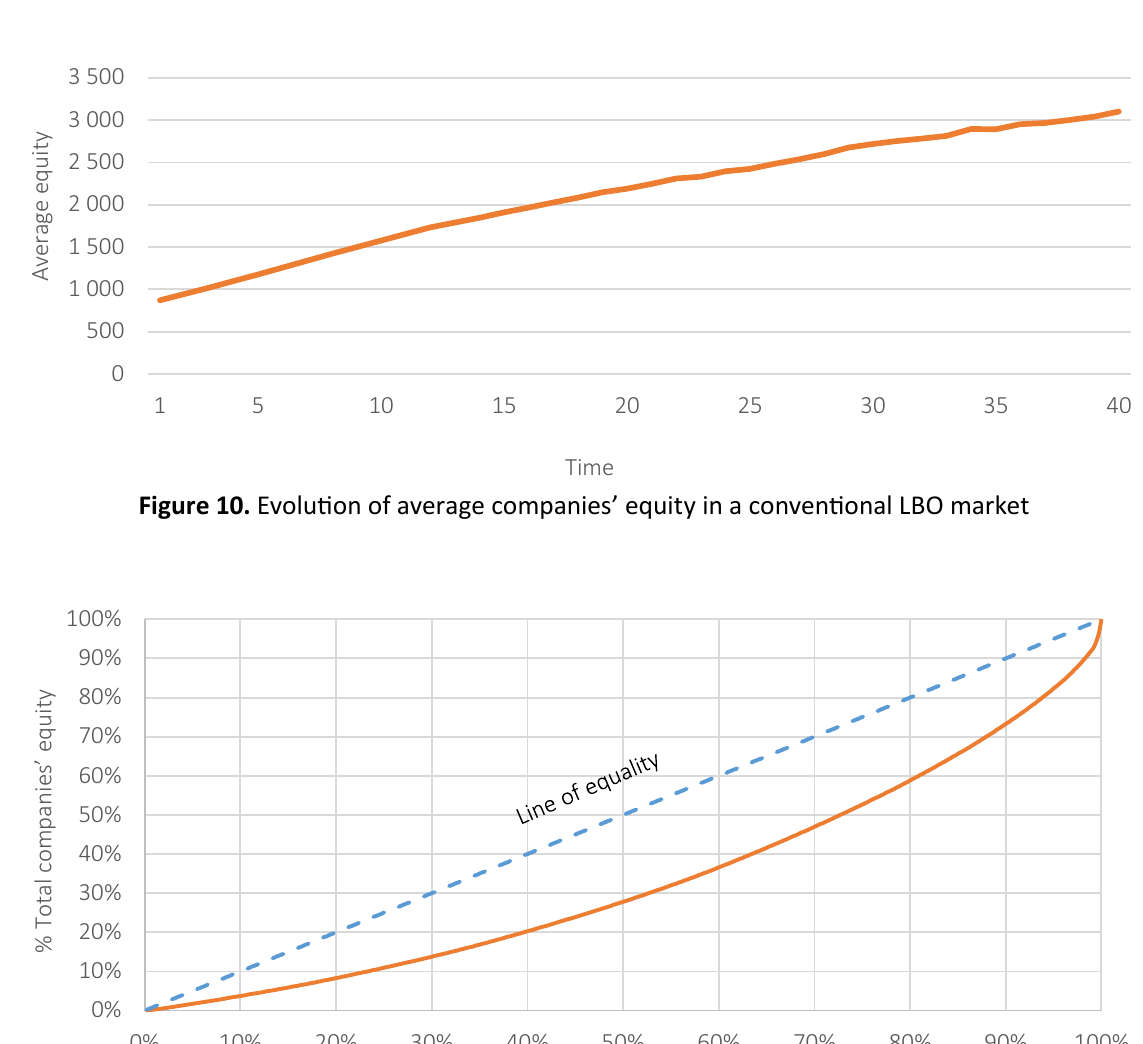
Figure 9. Evolution of Leverage ratio (Debt/Enterprise value) in conventional LBO market